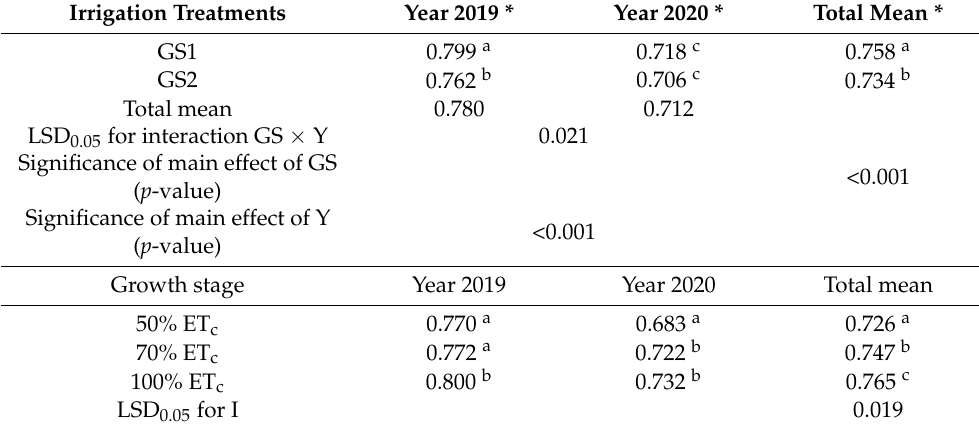
Table 6. Photosynthetic efficiency for the two years 2019 and 2020, for two growth stages. Data pre- sented are mean values, where LSD 0.05 is the Least Significant Difference at the 0.05 significance level.